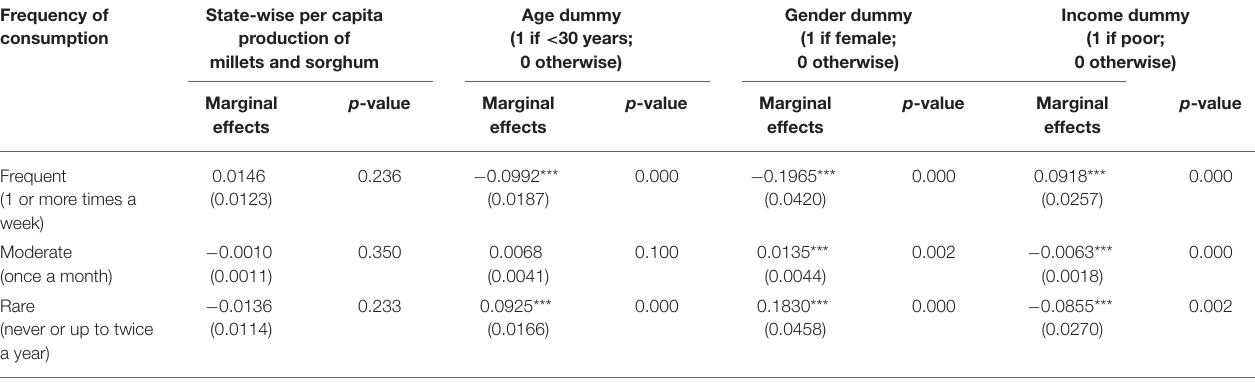
TABLE 9 | Marginal effects of state-wise per capita production of millets and sorghum on log odds of frequency of consumption in the urban areas ( n = 13,840). Frequency of consumption